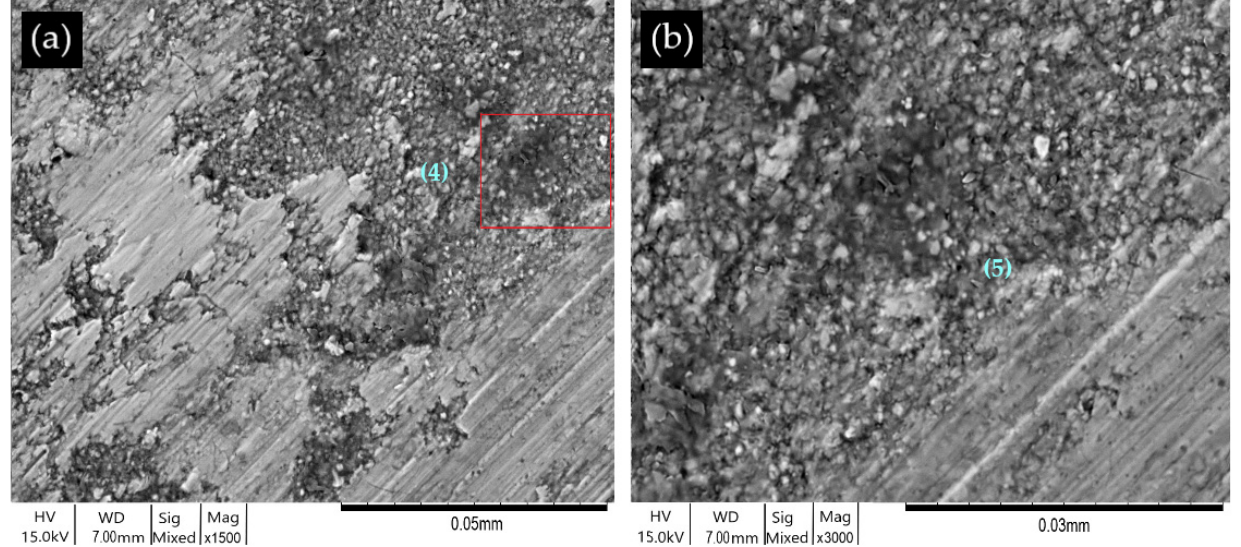
Figure 13. SEM images of Coating B after pin-on-disc Test 2b: ( a ) ×1500 magnification, ( b ) ×3000 magnification.